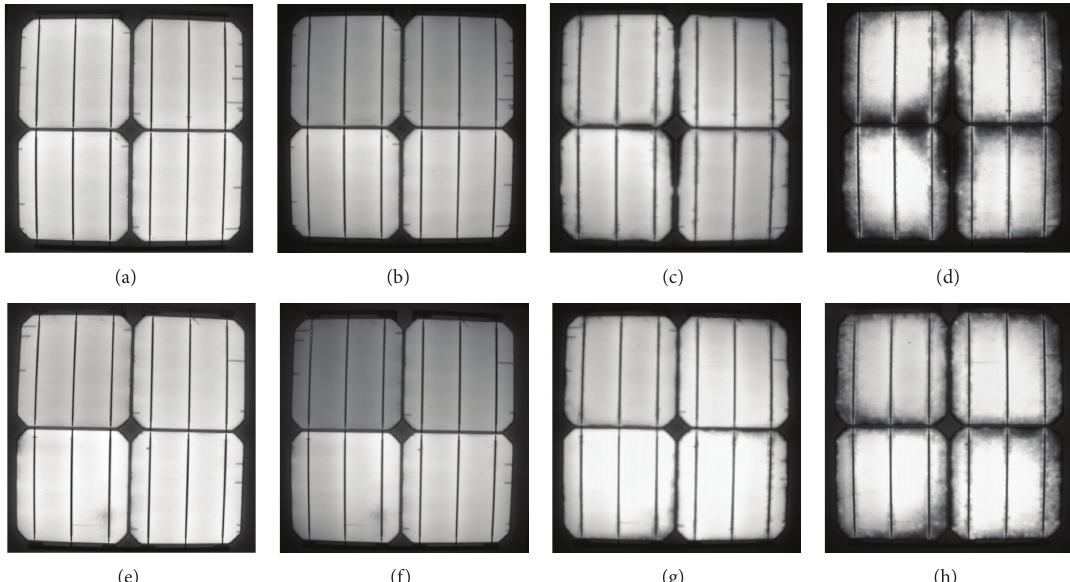
Figure 9: EL images of PV modules: the sample without Al after (a) 0 h, (b) 1000h, (c) 2000 h, and (d) 2500 h of DH exposure and the sample with Al after (e) 0 h, (f) 1000 h, (g) 2000 h, and (h) 2500 h of DH exposure.